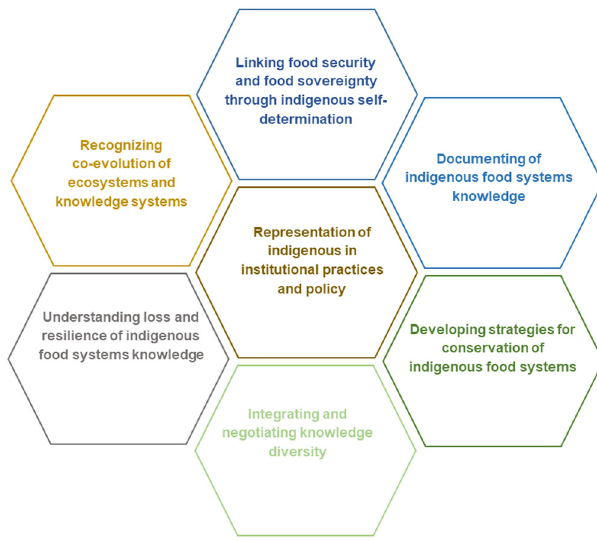
Fig. 1 Seven entry points for engaging indigenous food systems knowledge. Seven entry points indicates approaches ranging from better documentation and understanding of indigenous knowledge to inclusive practices of conservation and negotiation, to political challenges of marginalizing institutional practices and policies that can contribute to bridging indigenous and formal scienti fi c knowledge for sustainable and inclusive food